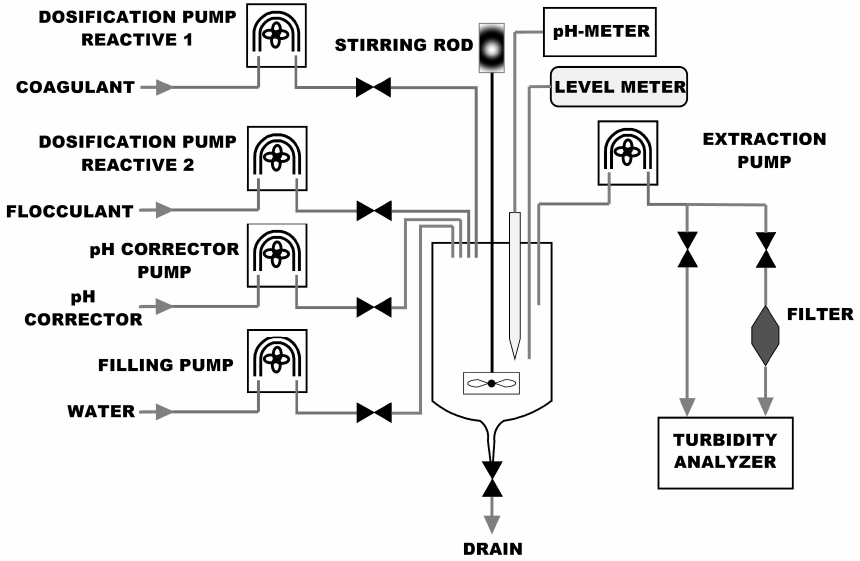
Figure 5. Fluidic diagram of the proposed solution including the sensors and actuators.